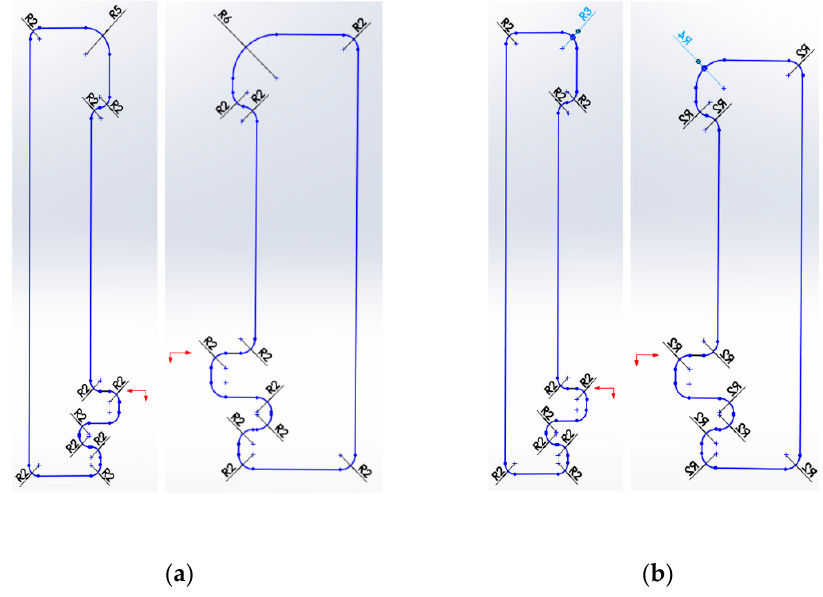
Figure 16. Lamella views: ( a ) First variant and ( b ) second variant.